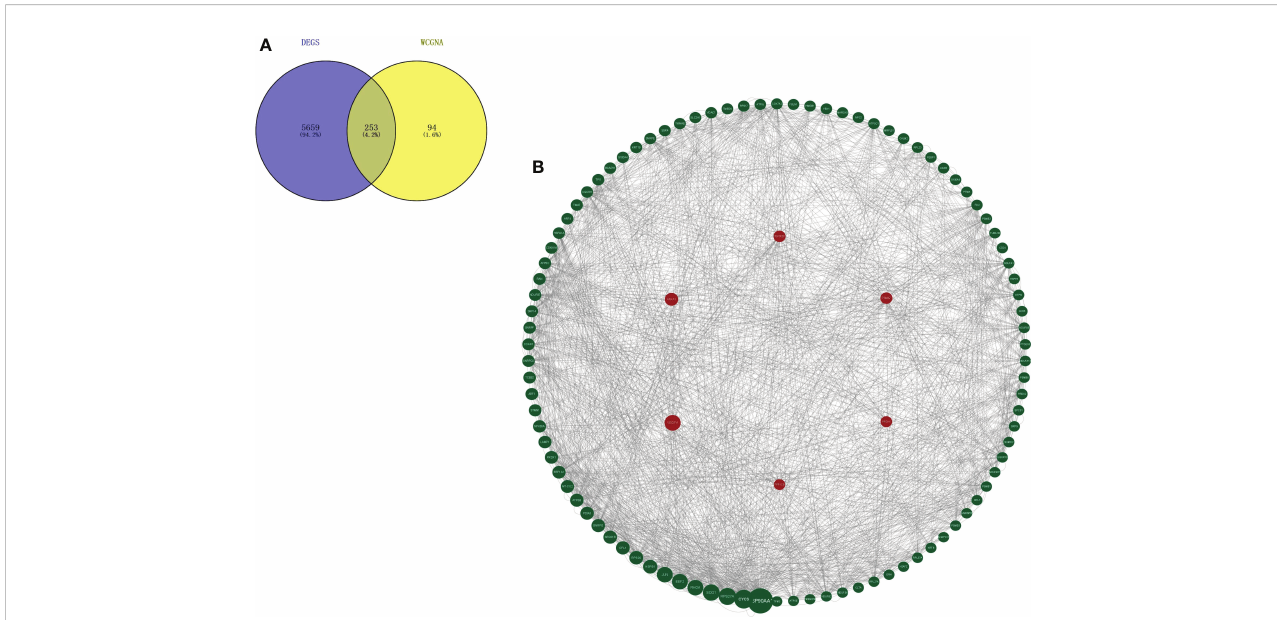
FIGURE 5 Key marker genes associated with the prognosis were explored. (A) Genes that overlap in turquoise module from WGCNA and DEGs between MIBC and NMIBC. (B) PPI diagram of top 100 genes based on the betweenness values by Cytoscape and the six hub genes is remarked with a red circle as background. WGCNA, weighted gene co-expression network analysis; DEGs, differentially expressed genes; MIBC, muscle-invasive bladder cancer; NMIBC, non-muscle-invasive bladder cancer; PPI, protein – protein